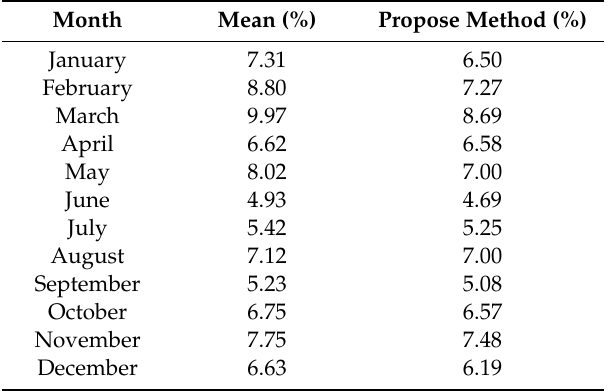
Figure 13. Scatterplot of measured value and propose ensemble model forecasted value. Table 2. NMAE for each ensemble model of forecasting in 2016.